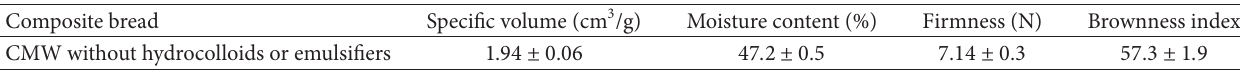
Table 2: Specific loaf volume, moisture content, firmness, and brownness index value of composite cassava-maize-wheat (CMW) breads without hydrocolloids or